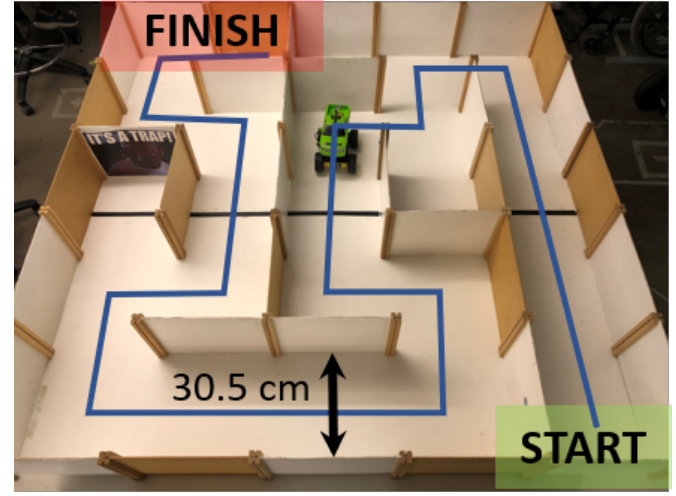
Figure 4. The maze executed by all participants was completed in the same direction (start to finish) for each trial. The blue line along the maze pathway (wall width = 30.5 cm; dowel protrusion = 0.75 cm each) depicts the nominal route, consisting of 14 straight segments and 13 total 90 ◦ turns (6 left, 7